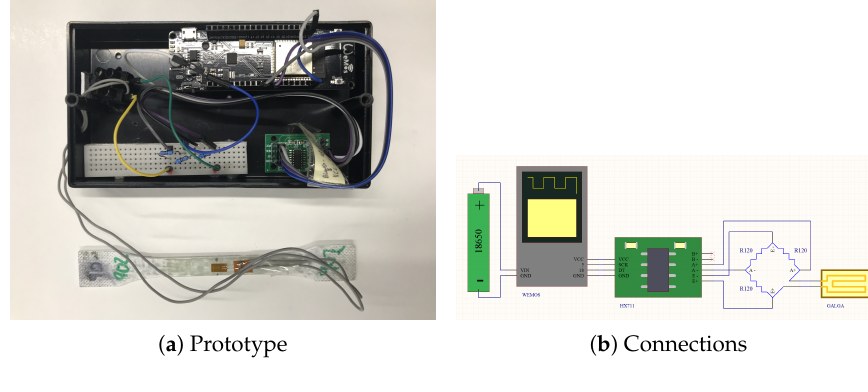
Figure 4. SmartFire